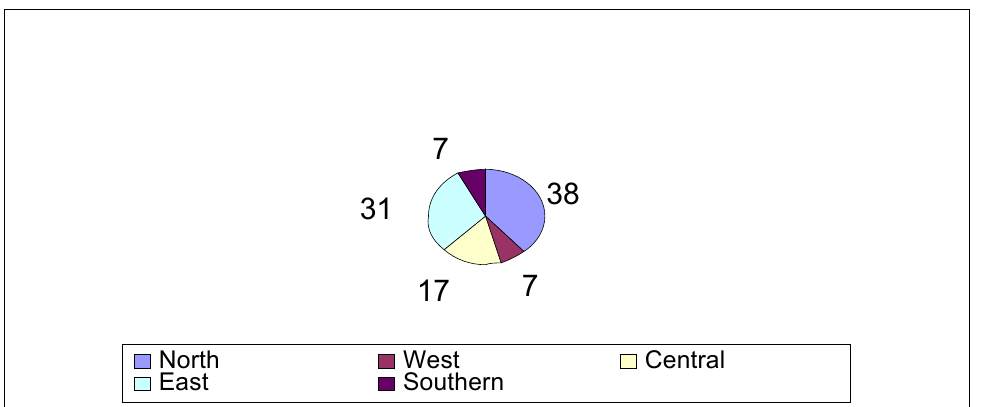
Figure 3: Geological disasters in Africa: 1974 to 2003